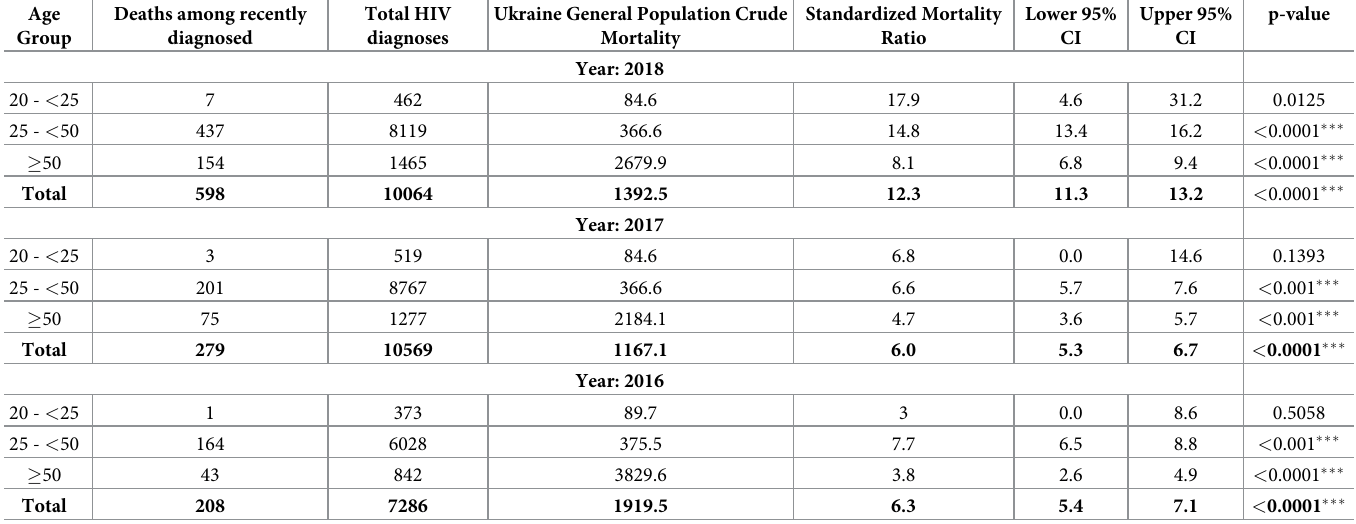
Table 2. Standardized mortality ratios by age group,